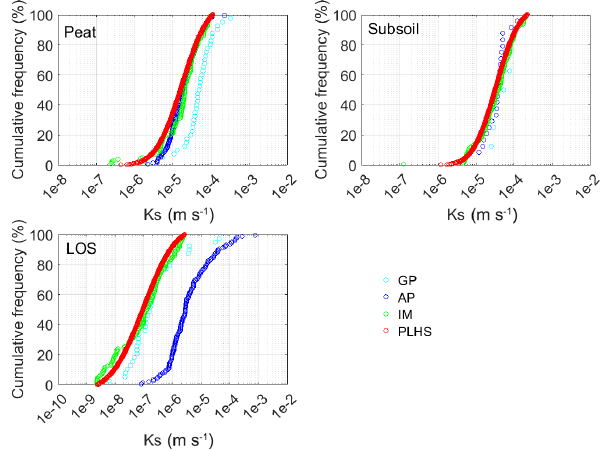
Figure 8. Comparison of the cumulative frequency distributions of the field-measured K s using GP and AP methods, and optimized (IM) K s values with the randomly sampled (PLHS) 700 K s values. The results shown are for peat, subsoil, and LOS soil